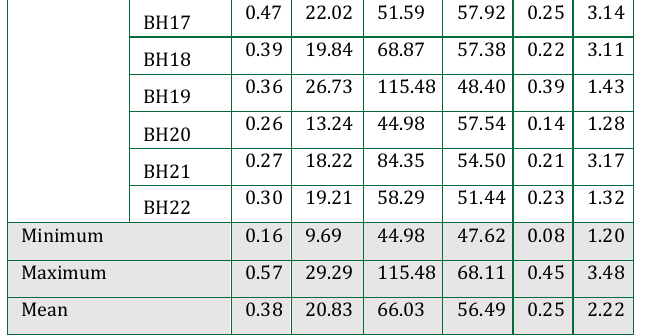
Table 5: Results interpretation for the various irrigation water Classification quality models for Khana L.G.A. Scheme